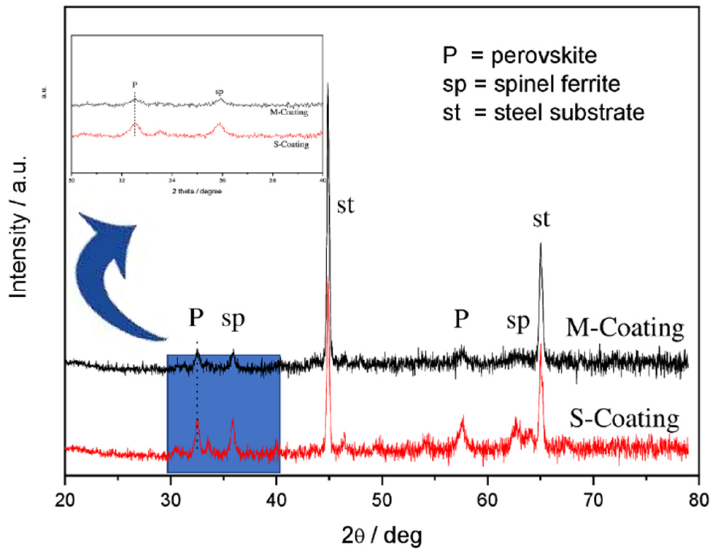
Figure 3. XRD spectra showing the phase composition of the thin-film perovskite coatings formed on the M-coating and S-coating samples.